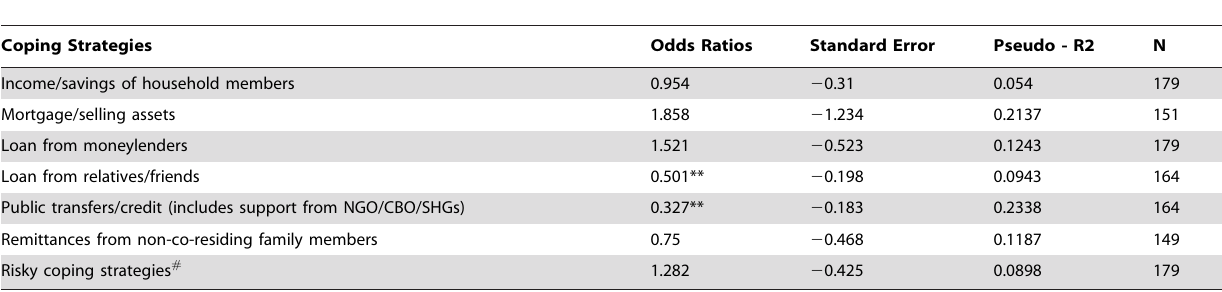
Table 2. Effect of climate shock intensity on use of different coping strategies, Sundarbans, West Bengal, India.